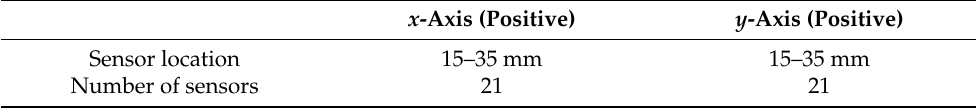
Table 3. Location and number of the four measuring